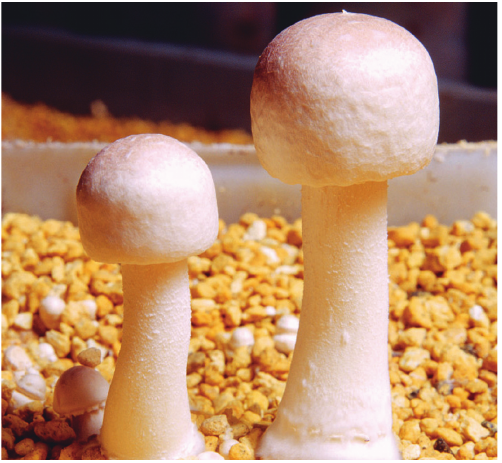
Figure 3: Female NIH/Ola mice were given either 200 μ l of the AndoSan AbM-based extract or PBS intragastrically on day 1 and 10 μ g of ovalbumin s.c. on day 0 and again on day 20, before exsan- guination for serum on day 26. IgE antiovalbumin levels were lower in the AbM- than in the PBS-treated groups ( P = 0 . 002). Similar results were found if AbM extract or PBS was given 3 weeks after the allergen immunization (not shown, please see [16]). IgG2a anti- ovalbumin levels (Th1 response) tended to show the opposite result (not shown). From [16], previously published by a BMC journal, which allows